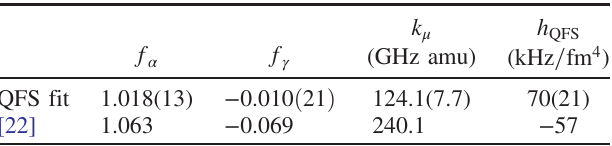
TABLE X. Best-fit parameters for the 3D King relation with the QFS term as the origin of the nonlinearity. In the QFS fit, the error of each fit parameter is evaluated as 1 σ . The second line is the coefficients at m ¼ 10 eV calculated by the electronic factors given by Ref.